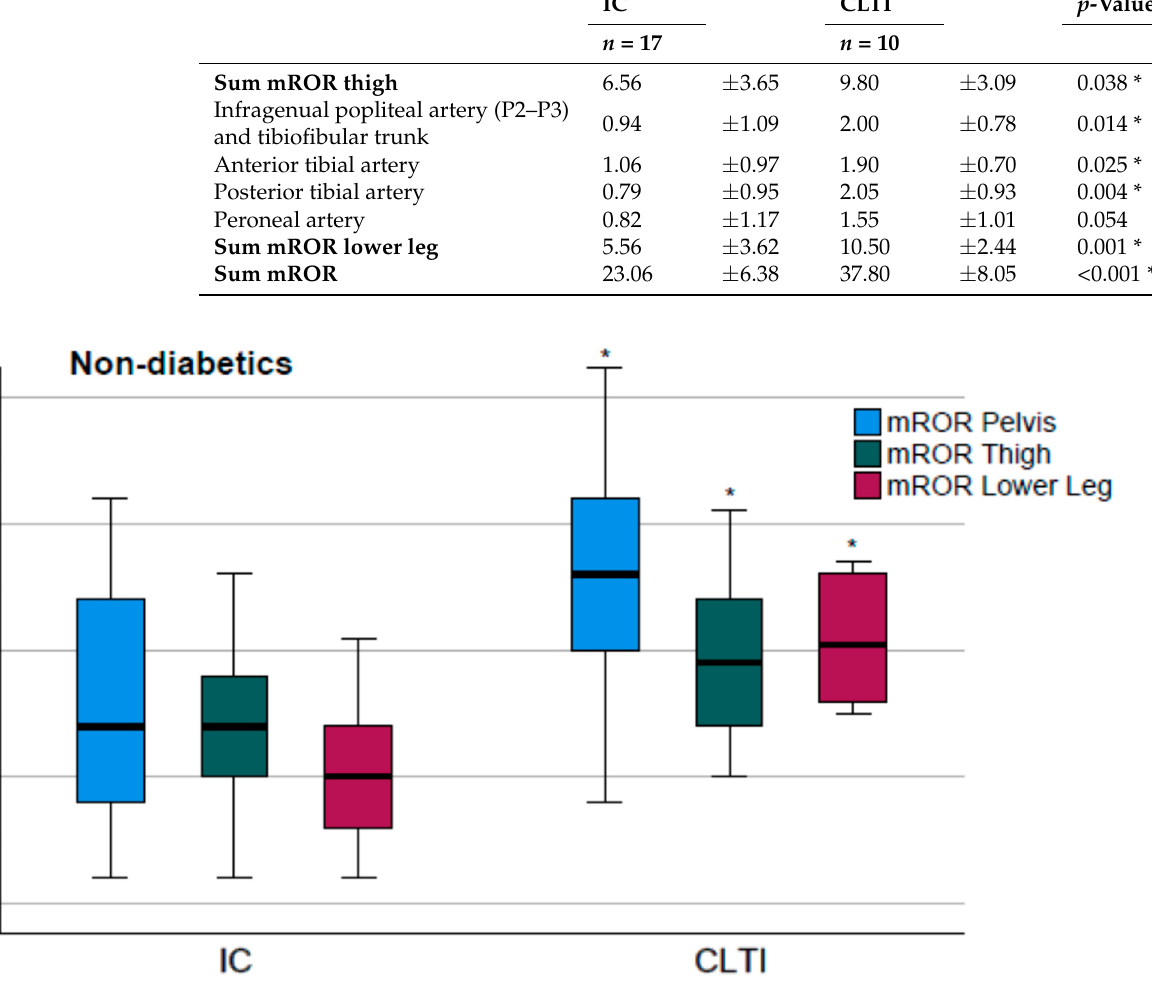
Figure 2. Subgroup analysis of the modified runoff resistance (mROR) scores of the three main arterial levels of intermittent claudication (IC) and chronic limb-threatening ischemia (CLTI) in non-diabetic patients. An asterisk * marks a significant difference.